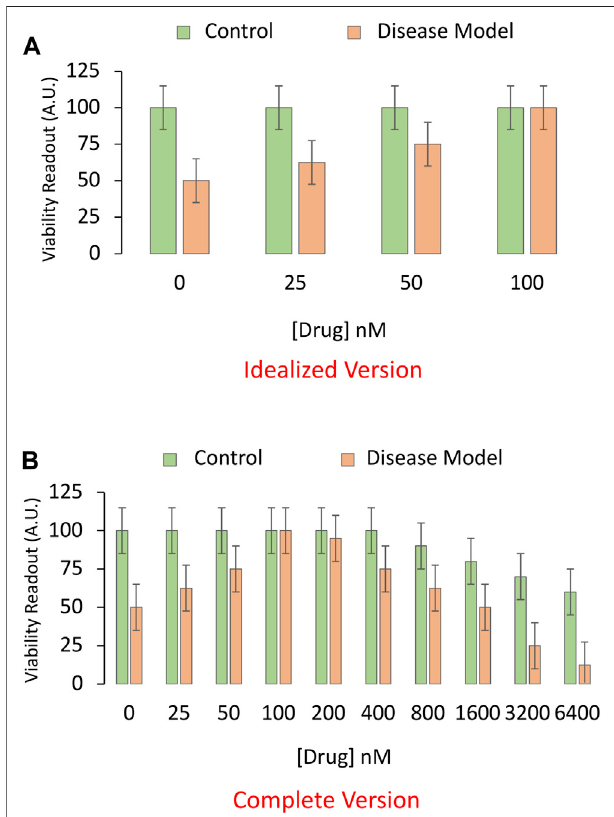
FIGURE 2 | Idealized versus realistic versions of concentration-effect graphs for the pharmaceutical drug candidate. (A) A sensitive and speci fi c viability assay is used to measure the impact of the pharmaceutical drug candidate on the survival of cultured cells in an experimental model of disease. Here, the toxicity-inducing stimulus is applied to induce the disease model at LC 50 values (4 μ M from Panels 1C,D ; shown as orange bars). An equivalentvolumeofvehicleisappliedasthenegativecontrol(shownasgreen bars). In this example, the drug candidate alleviates the toxicity of the preclinical disease model at relatively high concentrations, ranging from 25 to 100 nM. (B) A more complete concentration-effect graph reveals that higher concentrations of the drug candidate are toxic to basal viability (green bars) in cultured cells and also exacerbate the toxicity of the experimental disease (orange bars). Only the more complete version of the concentration-effect graph in panel (B) reveals that drug candidate has a low therapeutic index, de fi ned as the ratio of the concentration that elicits off-target toxicity to the concentration that elicits the desired therapeutic effect.